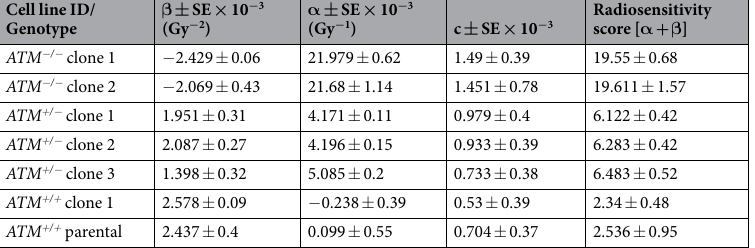
Table 3. Radiosensitivity coefficients ( α , β , c, and α + β ) in ATM -edited hTERT-RPE1 cell clones. α , β , and c coefficients were extracted from dose-response calibration curves in Fig. 2(b) using Cabas software. Relative capacity to repair DNA after acute γ -irradiation was assessed at a dose of 1